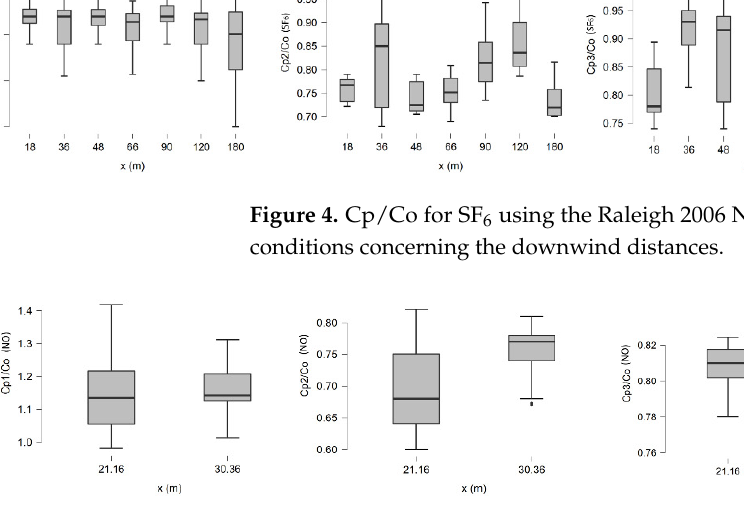
Figure 5. Cp/Co for SF 6 using the Idaho Falls Tracer Experiment (Data 3) for stable atmospheric conditions concerning the downwind distances.